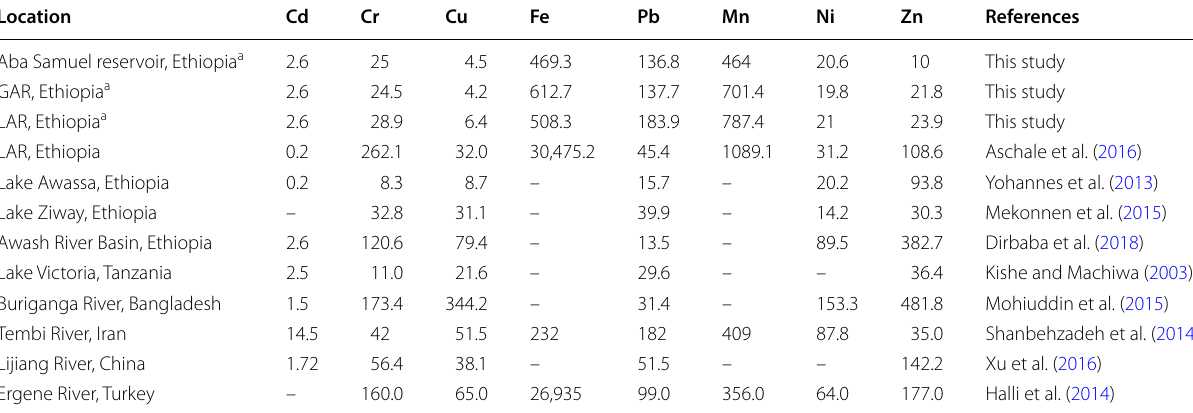
a Average of three sampling stations in the dry season was taken